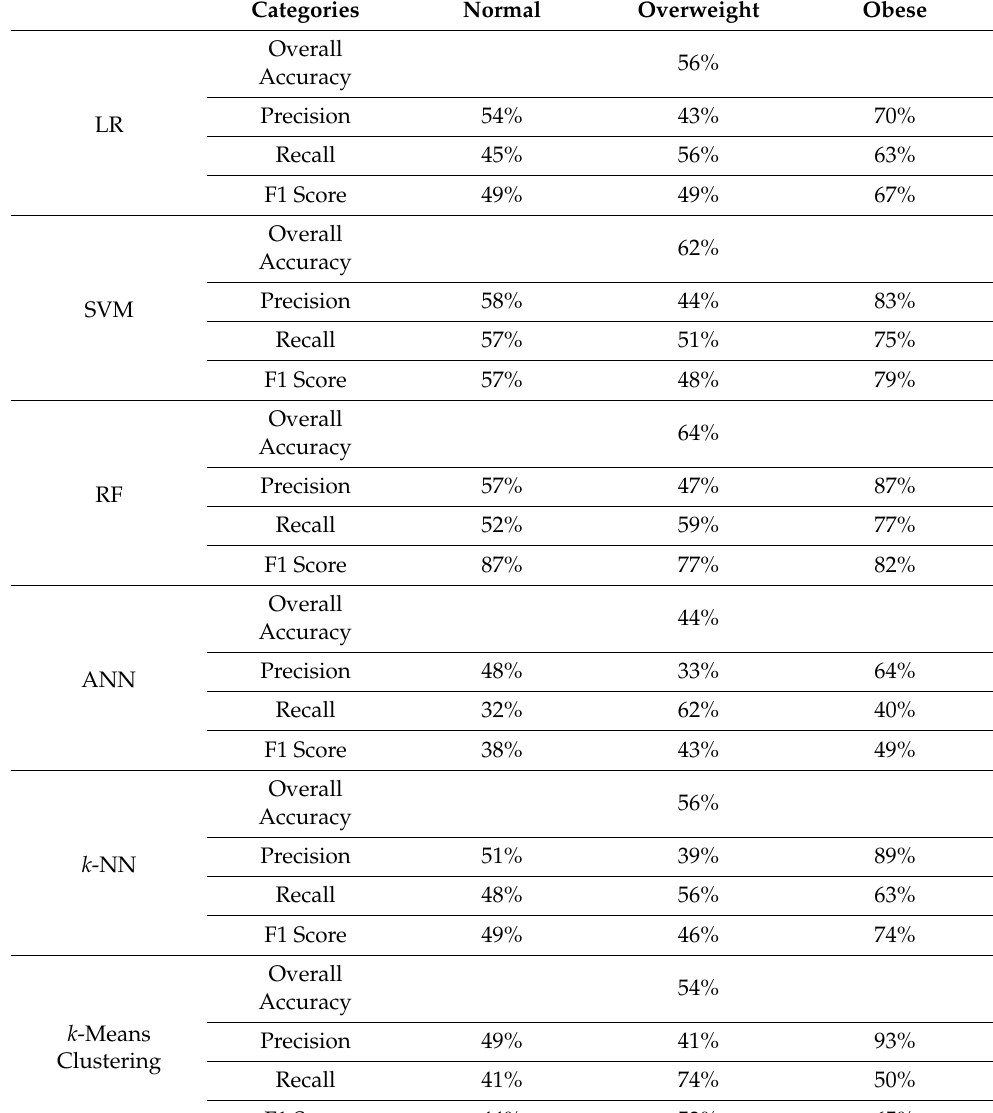
Table 10. Evaluation of performance for obesity prediction based on multiple random visits on a balanced dataset. Categories Normal Overweight